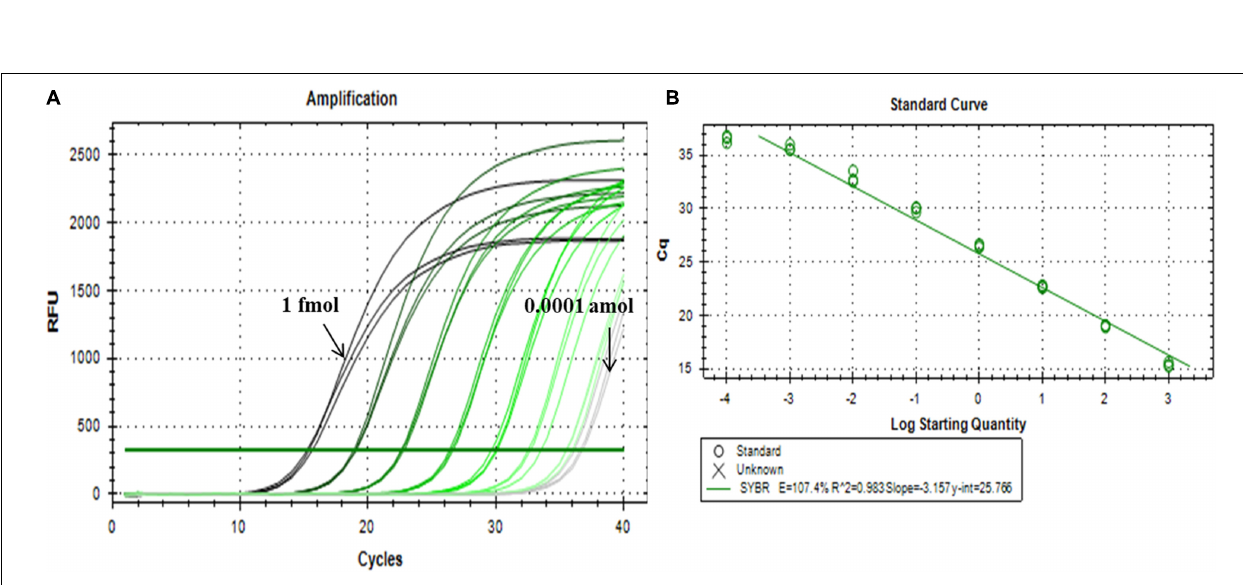
Frontiers in Plant Science |